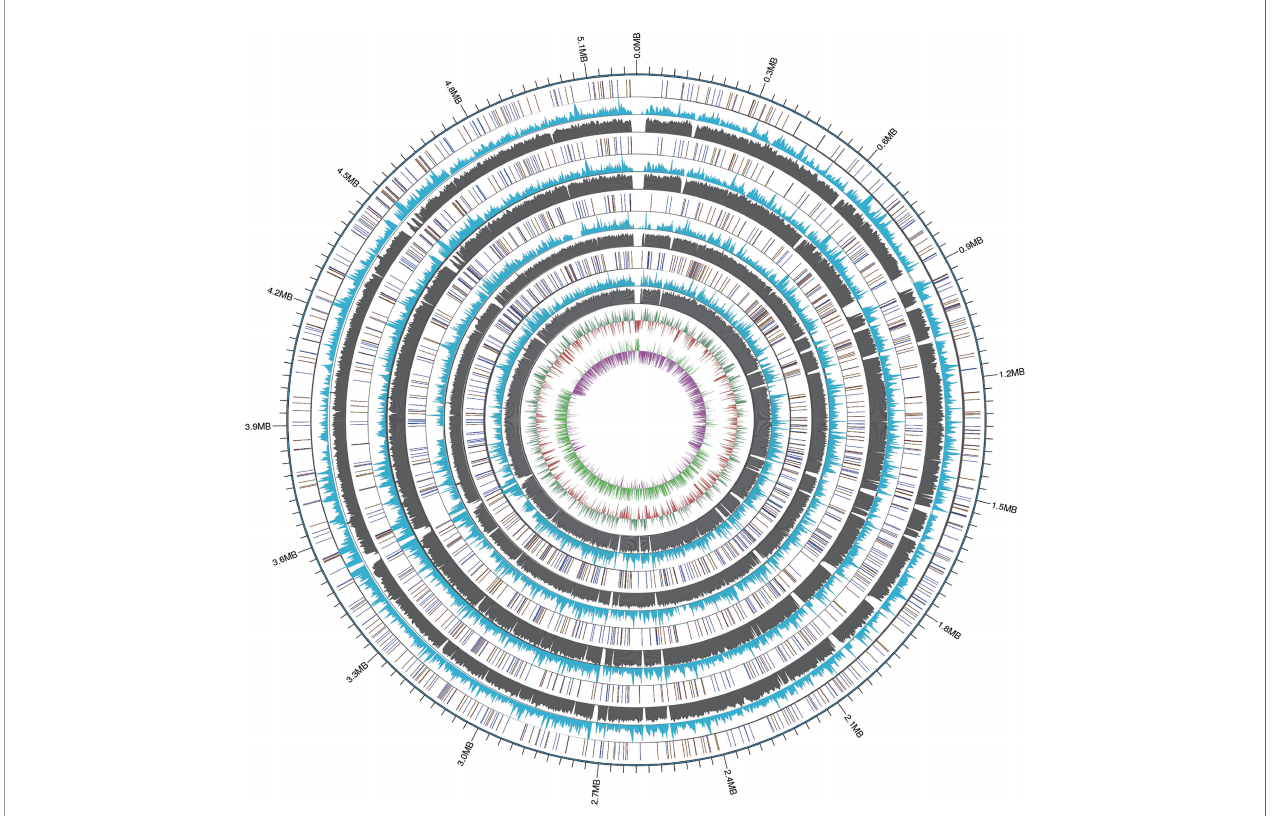
FIGURE 1 | The WGMP (Whole Genome Mutation Pro fi le) of 4 clinical isolates in this study. The outermost circle of the picture was the position of gene correspond to the reference genome (NCBI accession number: GCA_016025875.1). From the outside to the inside, InDel distribution, SNP number distribution, reads coverage depth, GC content of the reference sequence genome and GC skew value distribution of the 4 clinical isolates were shown. In the InDel distribution, the color of blue indicated deletion, yellow indicated